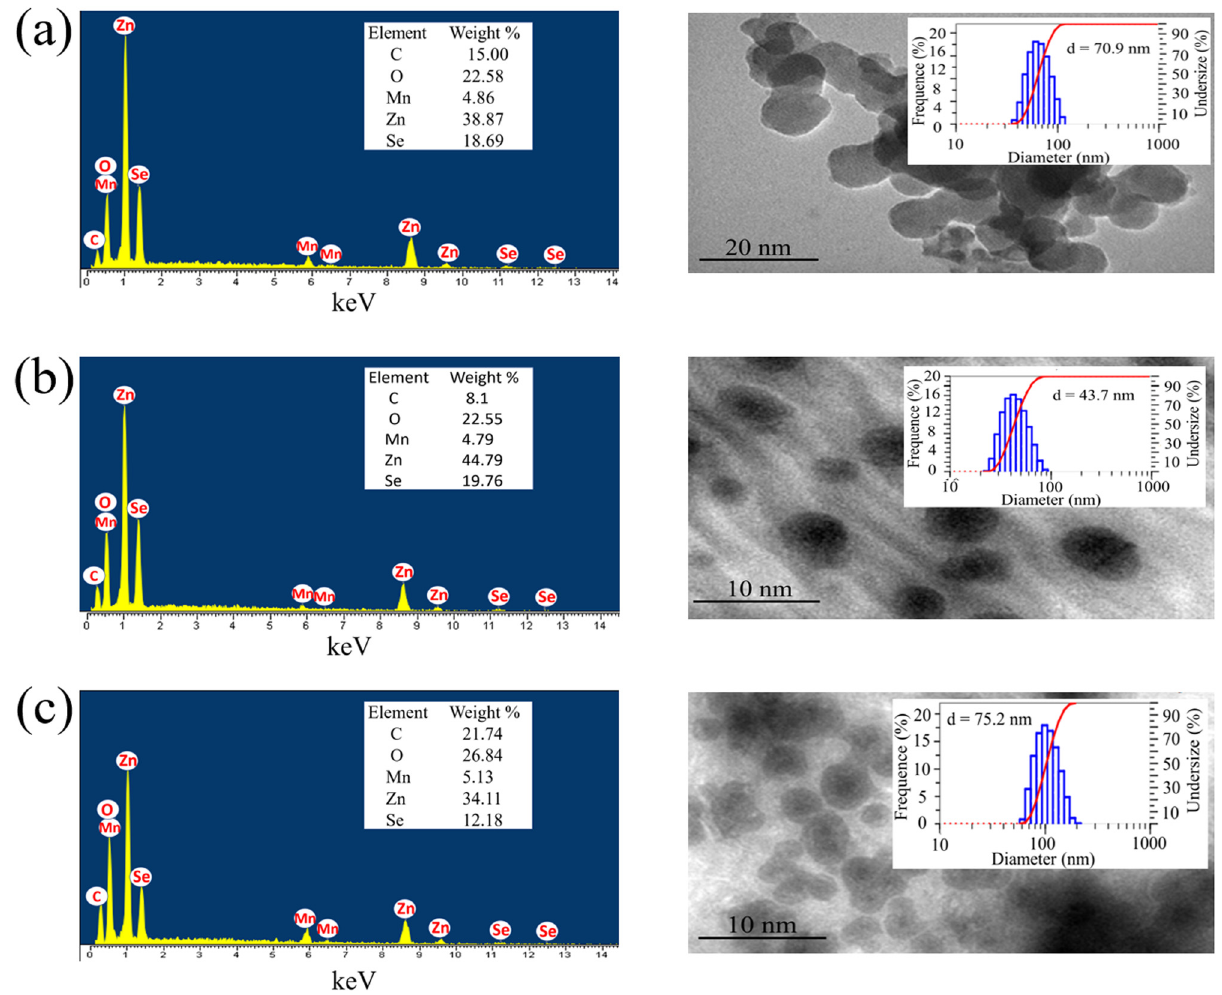
Figure 5: The EDX spectrum of the ZnSe:5% Mn capped with MPA, PEG, and starch samples.